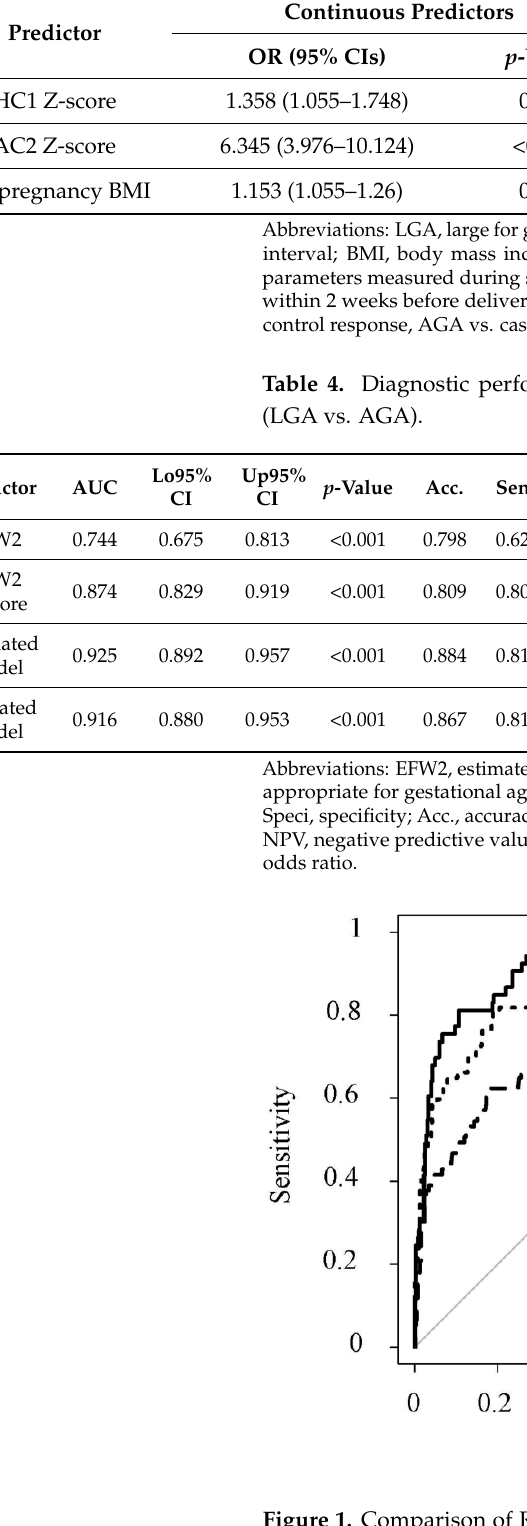
Figure 1. Comparison of ROC with EFW2 and EFW2 Z-score measured within two weeks before delivery and prediction model using type as binary response. ROC, receiver operator characteristic curve; EFW, estimated fetal weight.